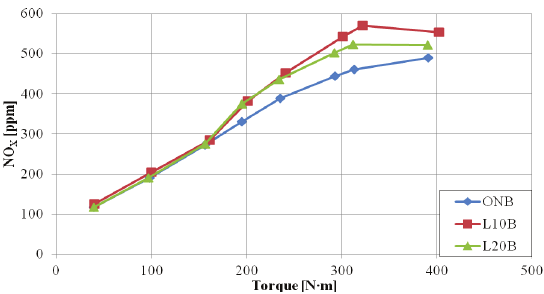
Fig. 3. NO x concentration for injection timing B and n = 1400 rpm